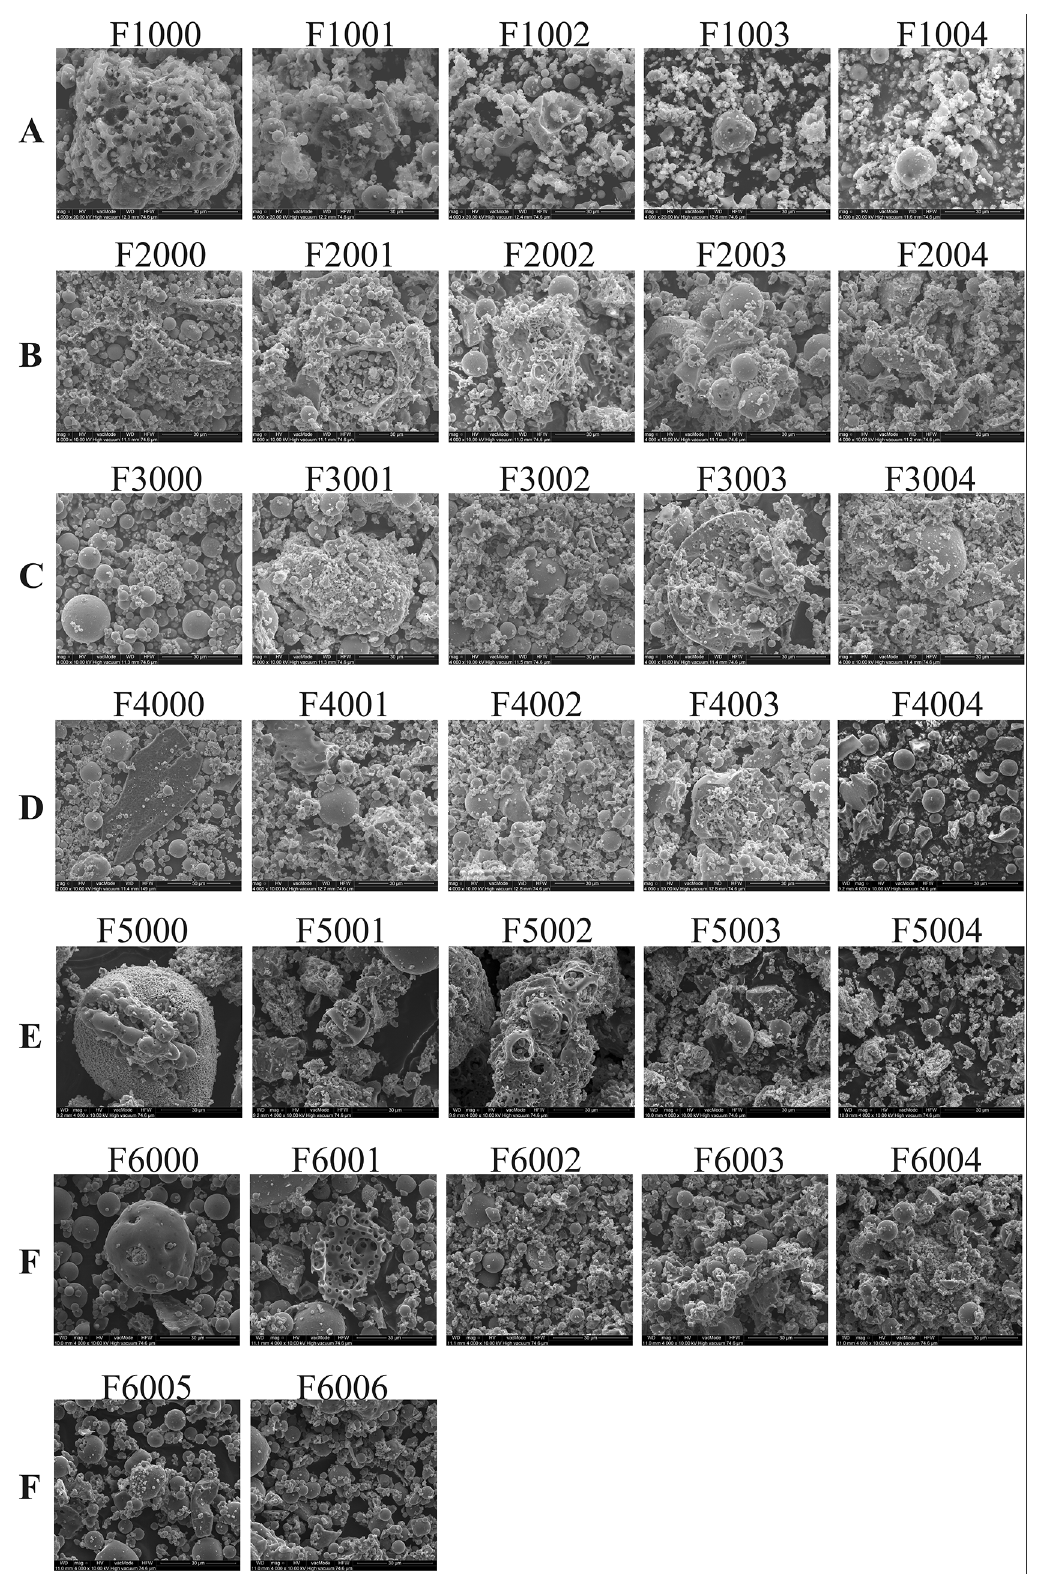
Fig. 2 SEM micrographs of raw fly ashes with their derivatives after grinding process ( a FA Skawina, b FA Siekierki, c FA Jaworzno, d